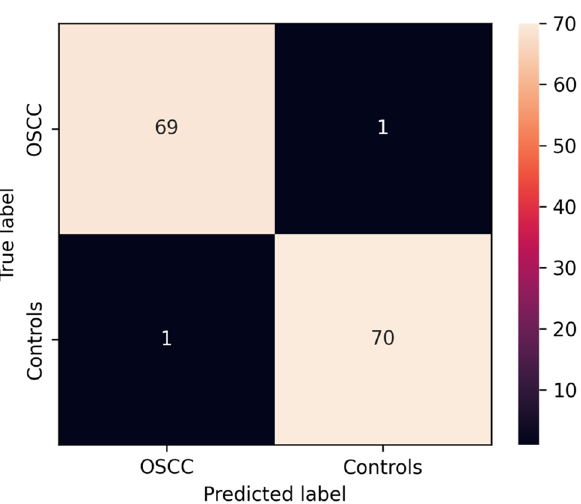
Figure 3. Confusion matrix illustrating the binary classification